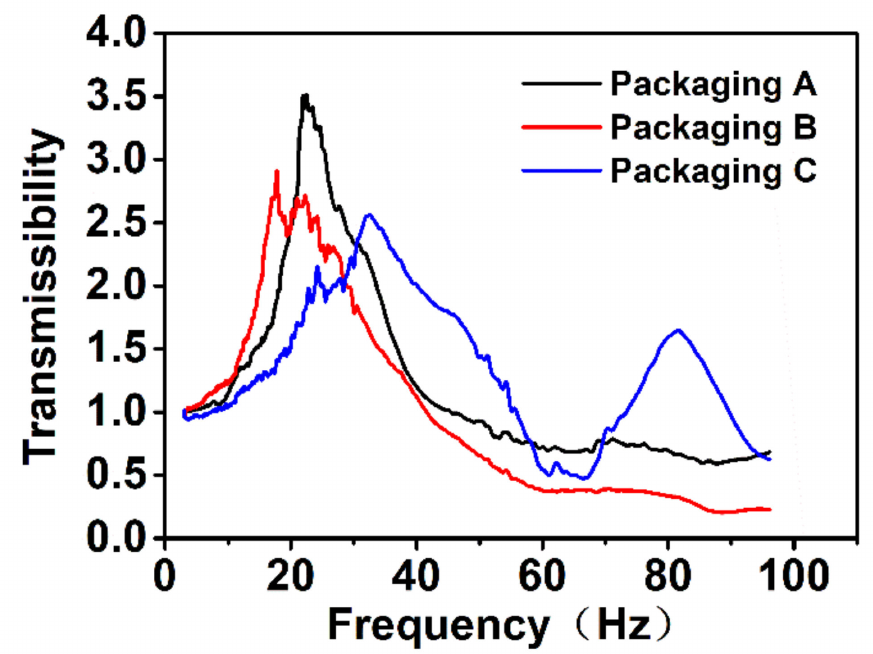
Figure 5. Vibration transmissibility–frequency curves of the three packaging